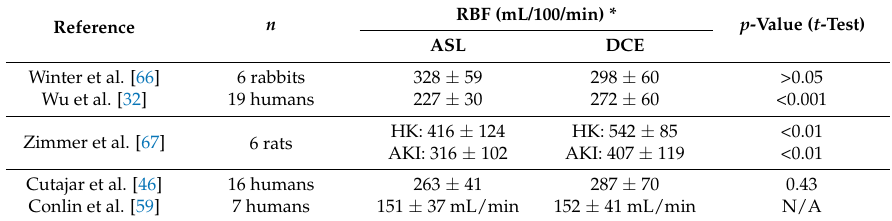
Table 3. Comparison of RBF estimates obtained by ASL and dynamic contrast-enhanced MRI (DCE-MRI).